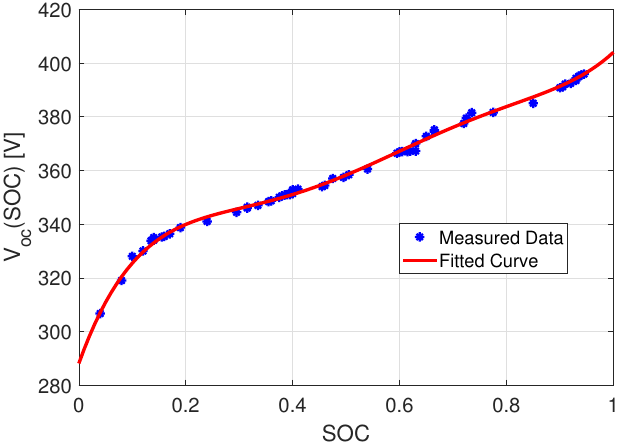
Figure 4. Estimated and fitted V OC vs.